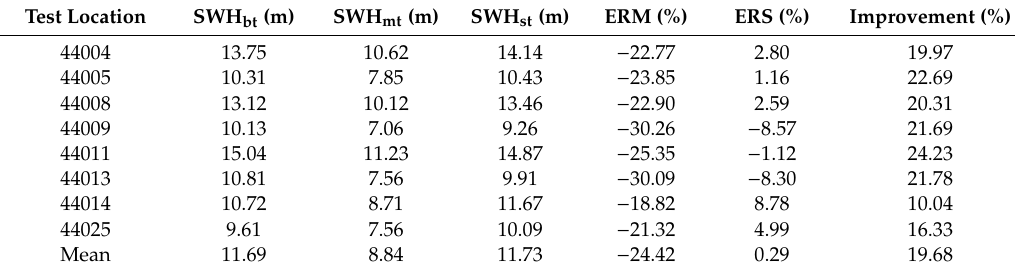
Table 4. Atlantic Coast: results for T R = 100